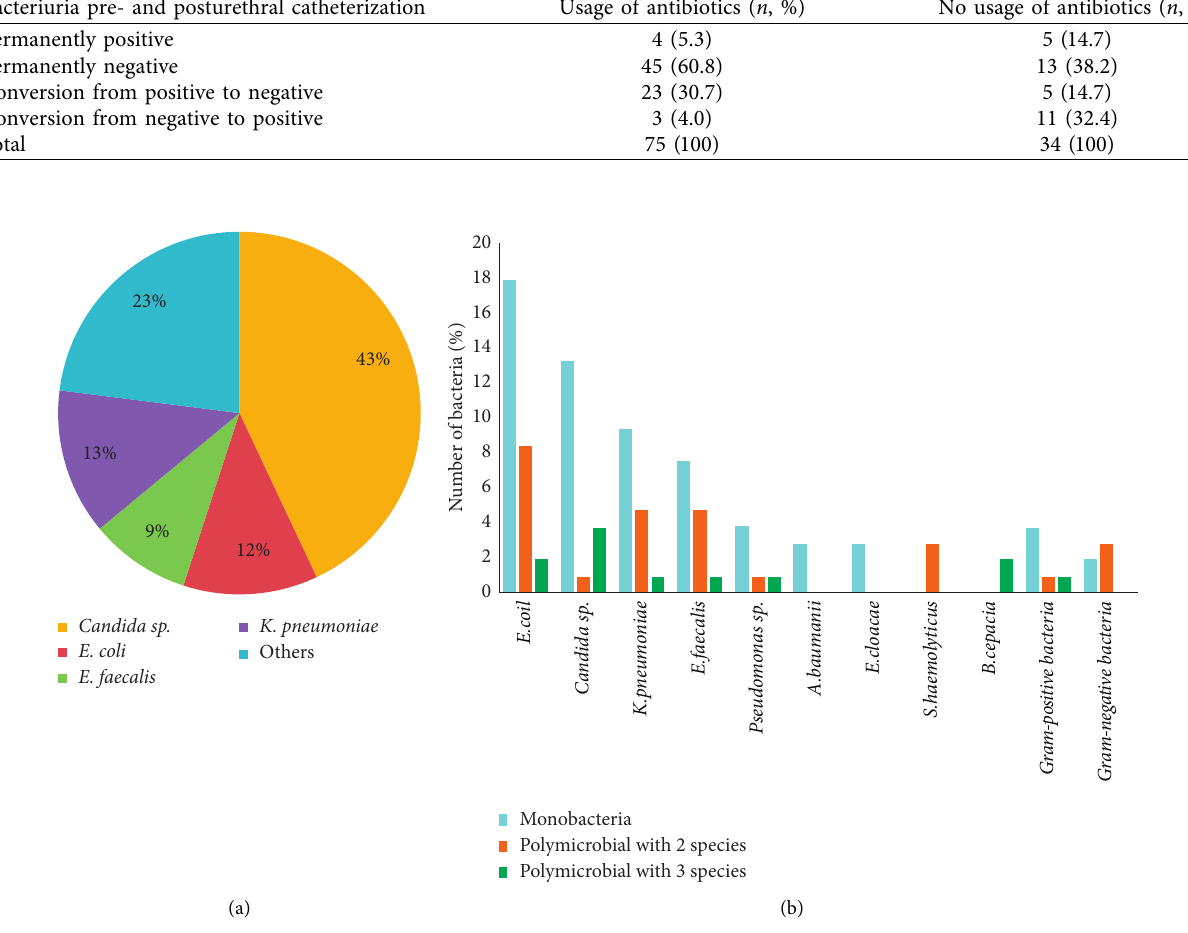
Figure 1: Isolate Distribution in (a) urine culture and (b) catheter culture. Candida sp. were found as the dominant microbes in the urine with a percentage of 43%, followed by E. coli at 12%, E. faecalis at 9%, K. pneumoniae at 13%, and other microbes at 23% (1(a)). E. coli was the dominant microbes in the catheter as monomicrobial or polymicrobial. B. cepacia was also found in the catheter but not found in the urine